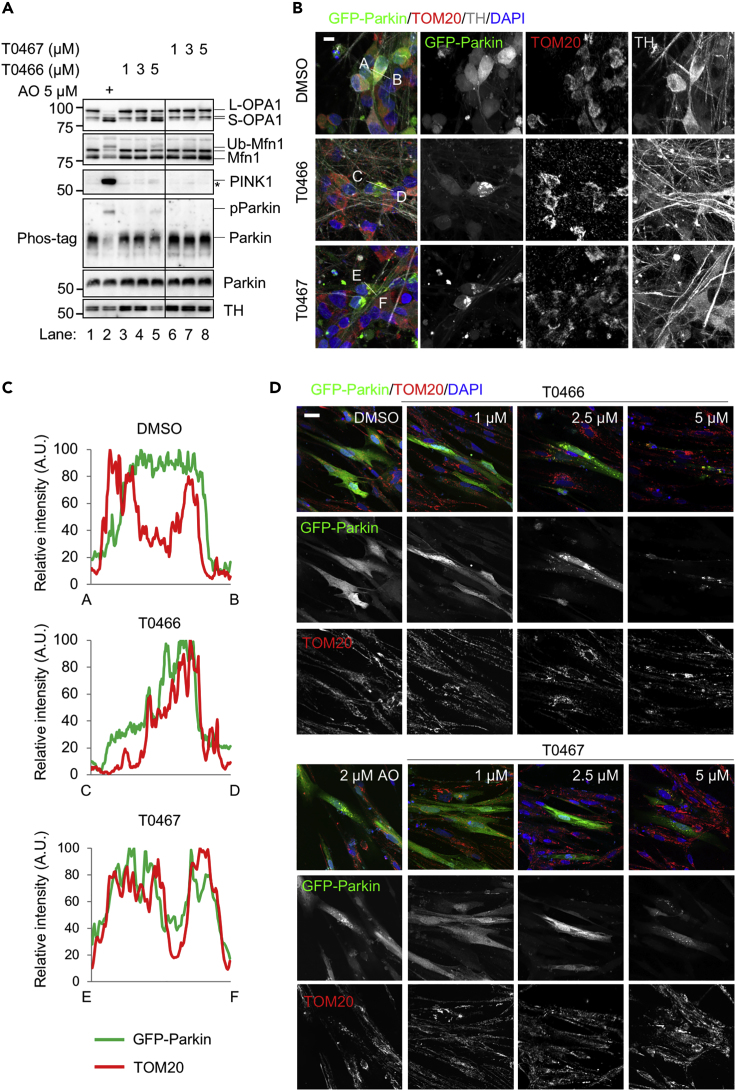
T0466 and T0467 Activate Parkin in Human Dopaminergic Neurons and Myoblasts(A) Effects of T0466 and T0467 on the ΔΨm of dopaminergic neurons. Dopaminergic neurons differentiated from human iPSCs were treated with T0466 and T0467 at the indicated concentration for 8 h. Antimycin A and oligomycin A (AO) were used as mitochondrial uncoupling reagents. Asterisk, non-specific.(B and C) T0466 and T0467 stimulate Parkin mitochondrial translocation in dopaminergic neurons. (B) Dopaminergic neurons, with virally introduced GFP-Parkin (green), were treated with 1 μM T0466 or 2.5 μM T0467 for 8 h. Single channel images for GFP-Parkin and TOM20 are also shown (grayscale). Scale bar, 10 μm. (C) Line profiles of fluorescence intensity along cross-sections in the images shown in (B). A.U., arbitrary units.(D) Myotubes forming from skeletal myoblasts, with virally introduced GFP-Parkin (green), were treated with the compounds at the indicated concentrations for 8 h. Mitochondria were visualized using anti-TOM20 staining (red). Scale bar, 25 μm.See also Figure S4.